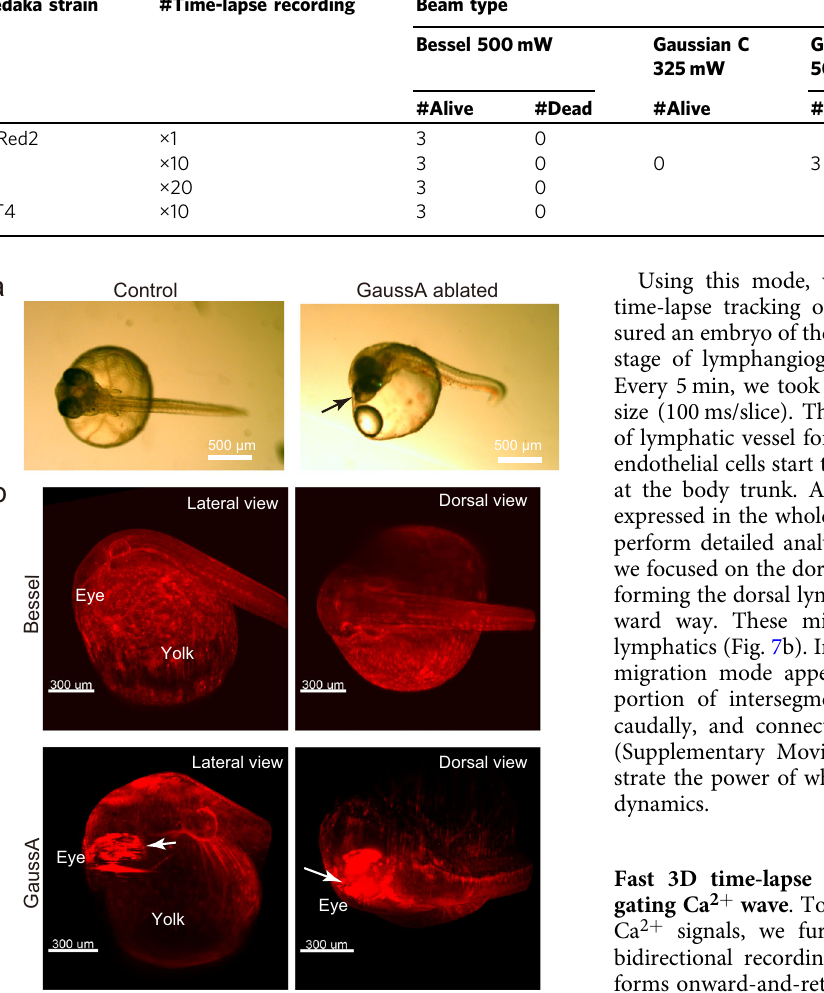
Fig. 6 Phototoxicity assessment. a Bright fi eld view of the 3 dpf embryos of the β -actin-DsRed2 strain after the phototoxicity experiment. Control indicates a gel-embedded embryo, which does not show signi fi cant damage. For the ablation experiment, the time-course 4D imaging was performed in 5-min intervals with 200 ms exposure/slice with 2 μ m steps, 2048 × 2048 pixels, ~600 slices. The arrow shows the air bubble created around the eye. b 3D view of the embryos viewed from the lateral and dorsal side. White arrows indicate strong fl uorescence emitted from the retinal pigments. a , b n = 3 biologically independent β -actin-DsRed2 strain embryos are examined for the different beam conditions of phototoxicity